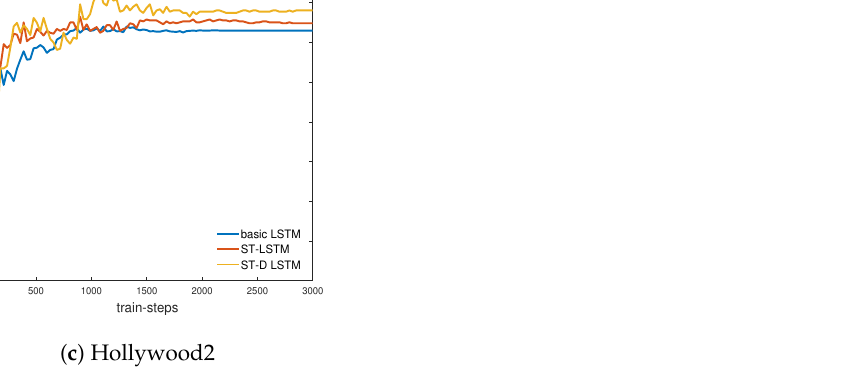
Figure 4. The comparison of different LSTM units on three datasets in accuracy.